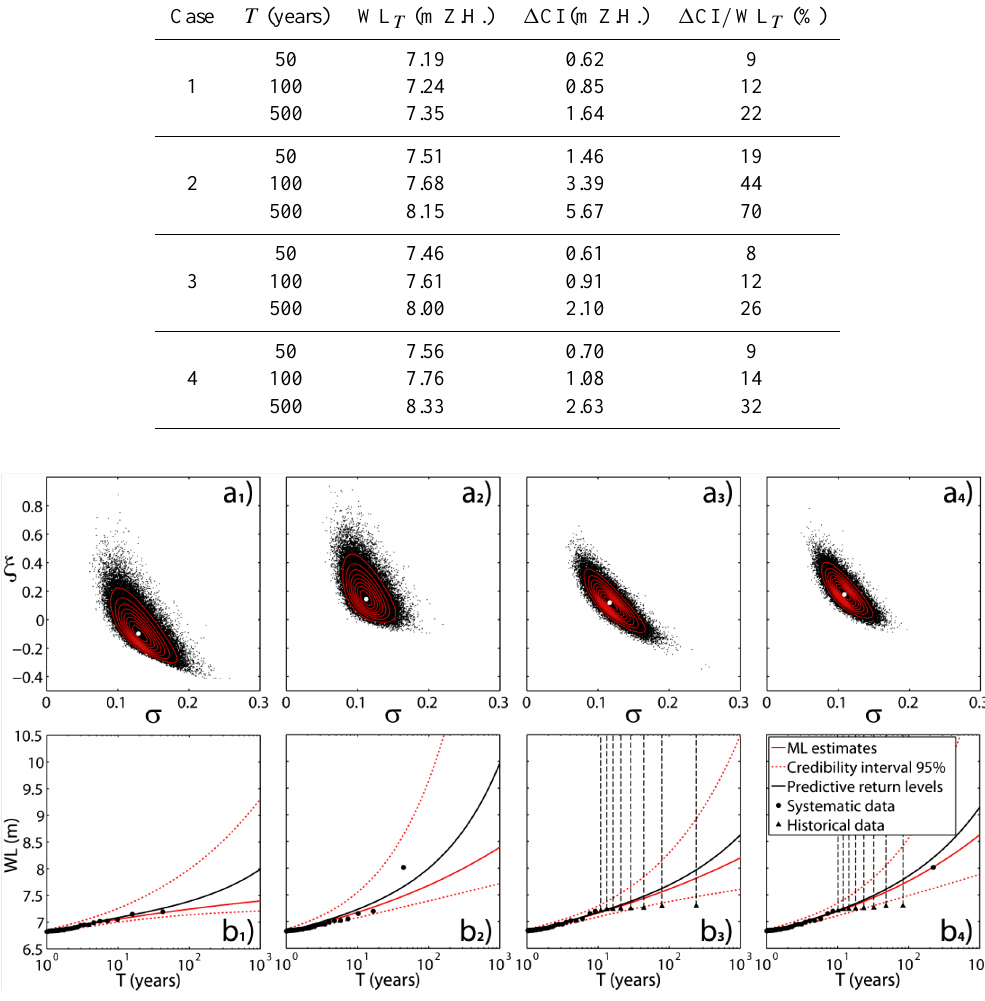
Figure 3. Results: (a) bivariate density contours of parameters ξ and σ . Black dots represent the Markov chain of 50000 simulations. The white dot is the mode of the bivariate density. (b) return-level plots for the following cases: (1) systematic data until the end of 2009, (2) systematic data until the end of 2010, (3) systematic data until the end of 2009 and historical information, (4) systematic data until the end of 2010 and historical information. The plotting positions of systematic and historical data are defined using the method developed by Naulet (2002) (see Appendix